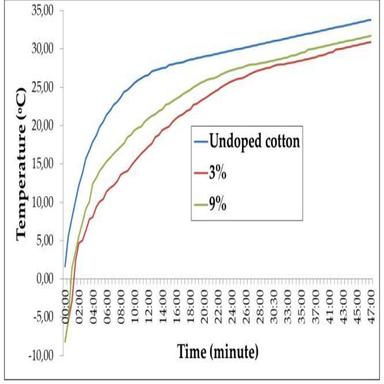
T-history results of PCM-Cott composite yarns produced at the optimal feeding rate of 77.5 mL/h for two different capsule concentrations.